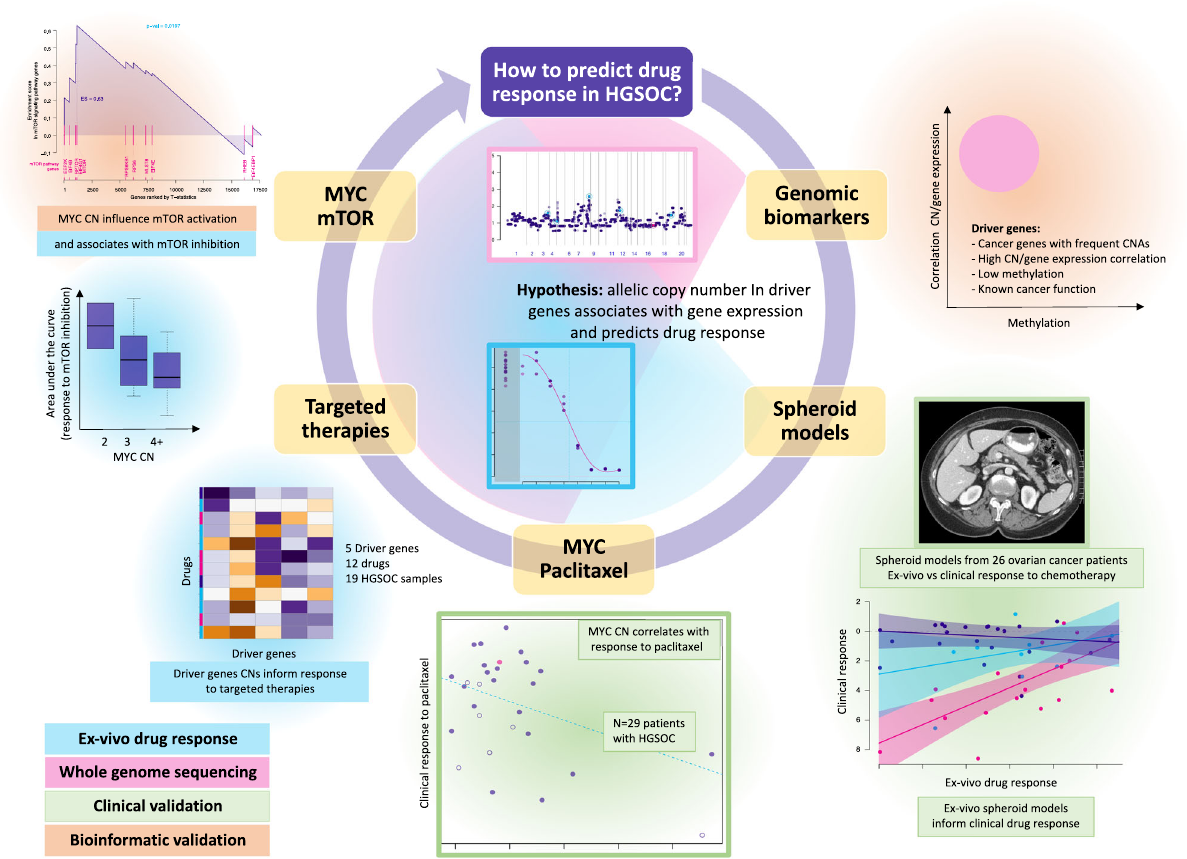
Fig. 1 | Diagram summarising the research question, hypothesis and main